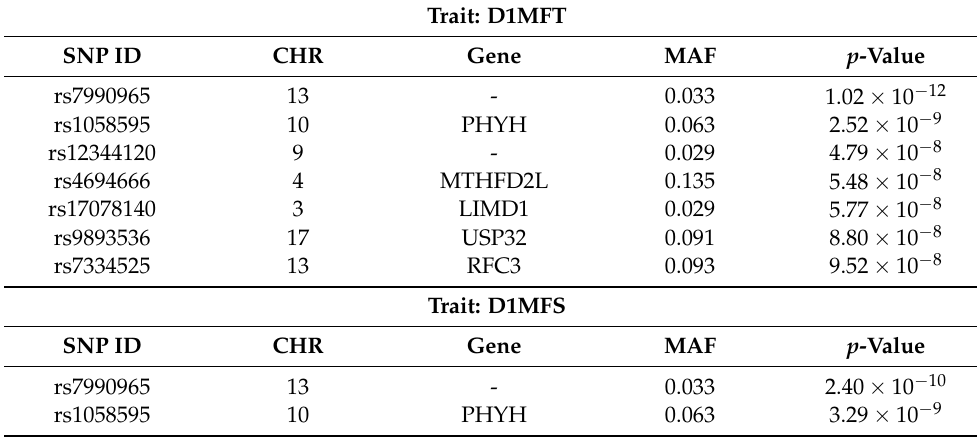
Table 4. Significant findings for dental caries GWAS scanning using single-marker association tests based on the ZINB model.